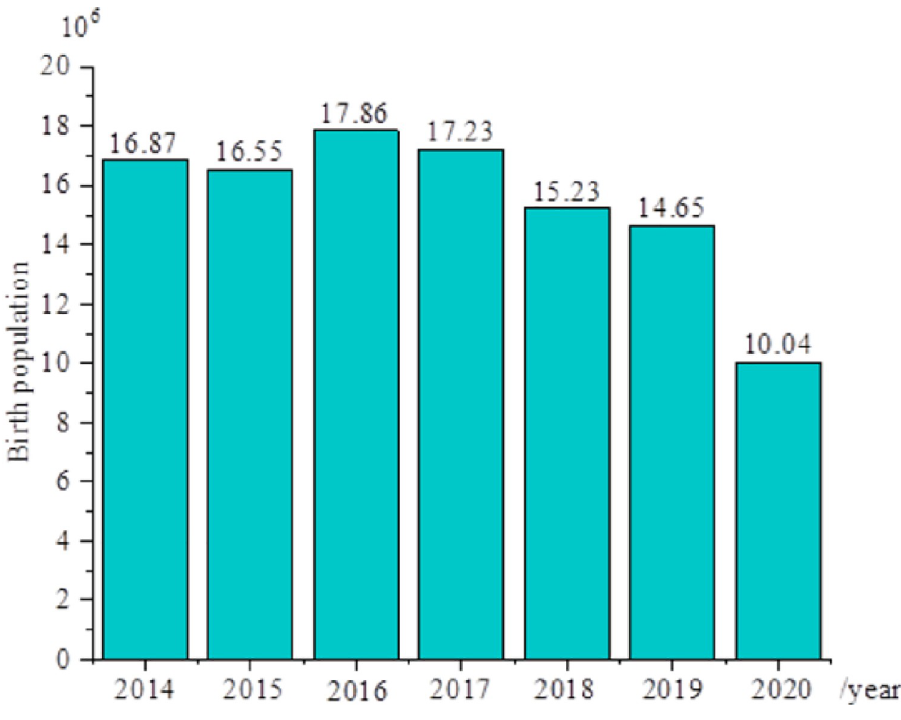
Fig 2. Birth population during 2014–2020.